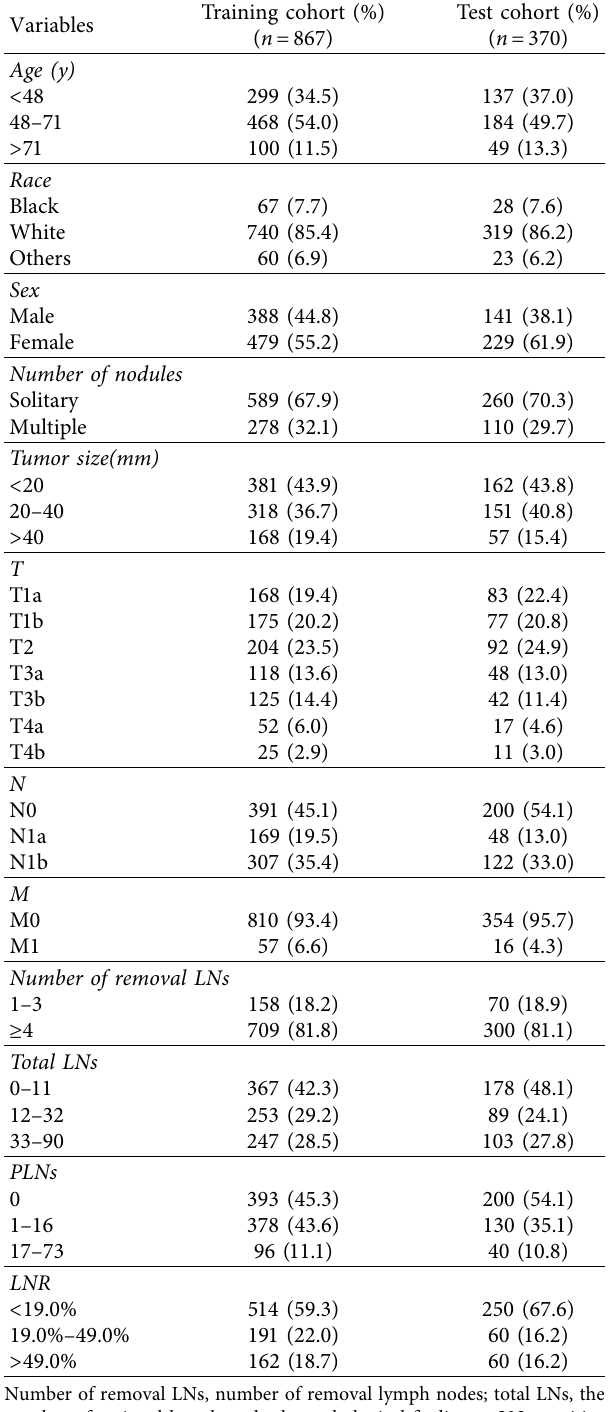
Table 1: Baseline demographic and clinical characteristics of MTC patients who underwent total thyroidectomy and neck lymph nodes